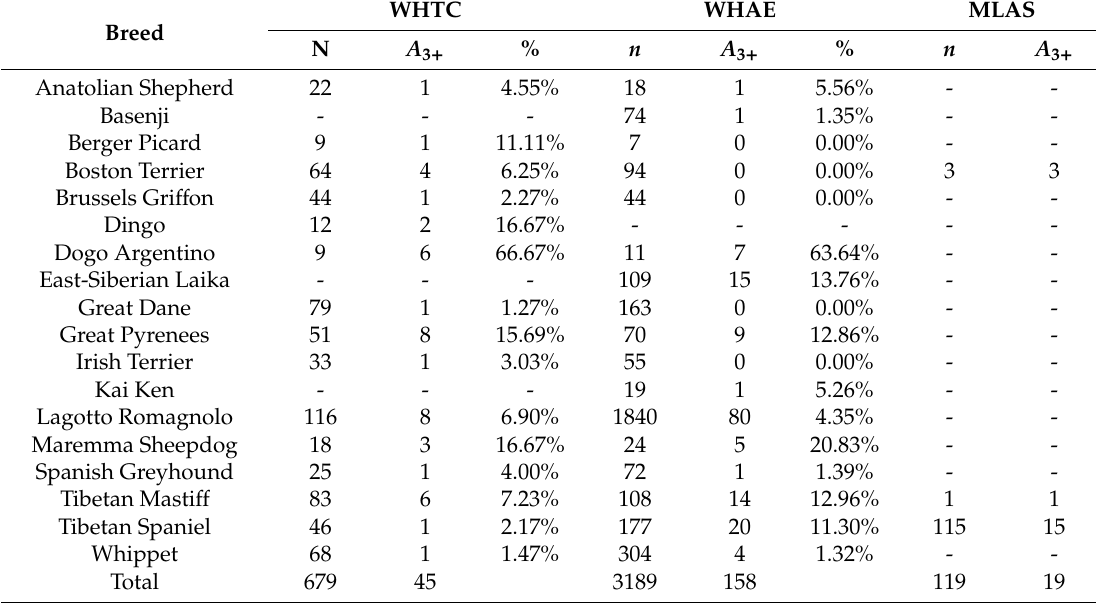
Table 1. Dogs from three datasets that genotype for three or more Agouti Signaling Protein ( ASIP ) alleles ( A 3 + ). The proportion of same-breed dogs that genotype as A 3 + are presented as a percentage of the total number of dogs for that breed within the given dataset. Supplemental dogs (Multi-Laboratory Agouti Supplement (MLAS)) were genotyped at any one of six alternate commercial genotyping laboratories. Since these multi-platform dogs were not randomly selected, population percentages were not produced. ASIP allele frequencies across cohort, as calculated according to current methodologies in the field, are presented in Table